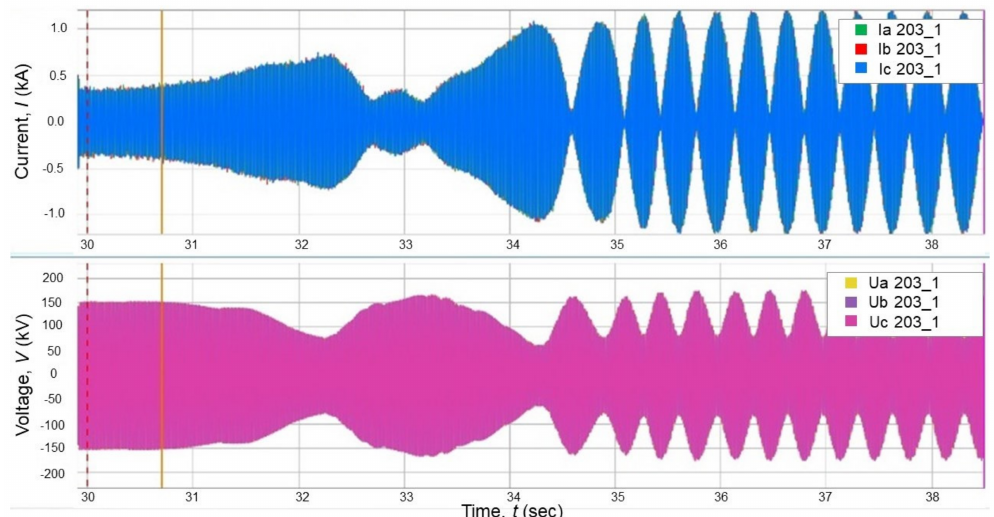
Figure 28. Plot of the recorded time series (voltages and currents) during the event of 15 September 2018, Unstable power